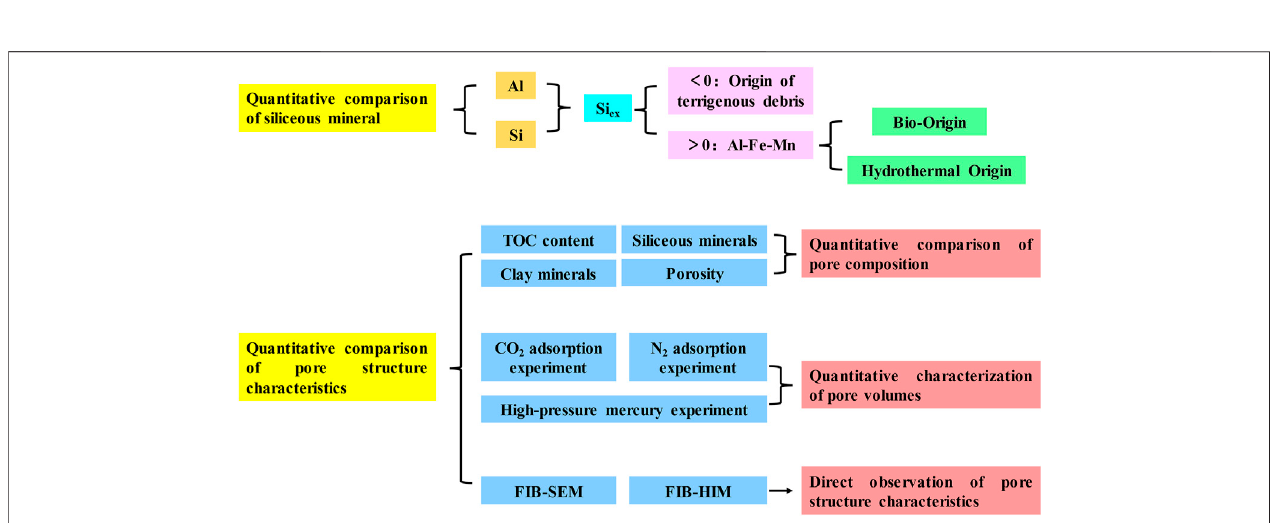
FIGURE 2 | Schematic diagram of the experiments used in each of the research components of this paper.